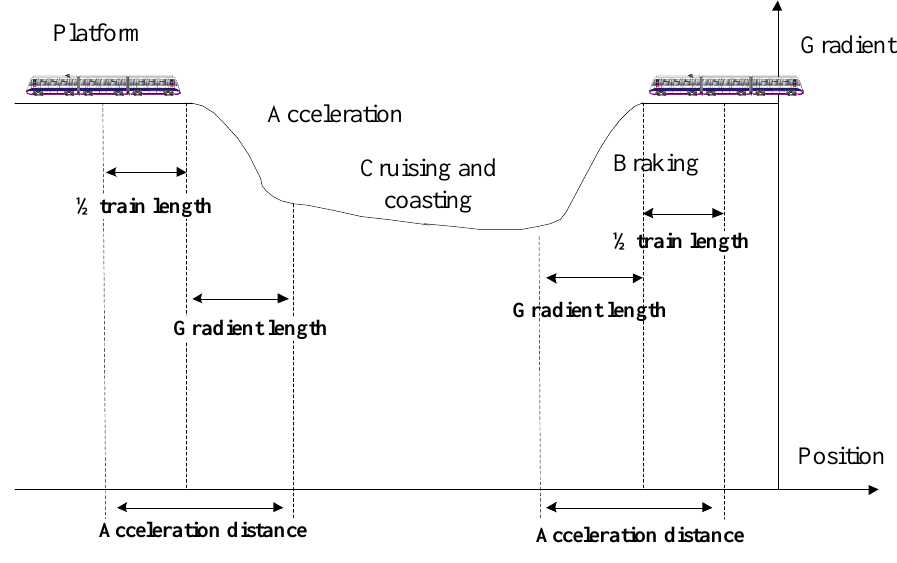
Figure 6. Design of energy-saving